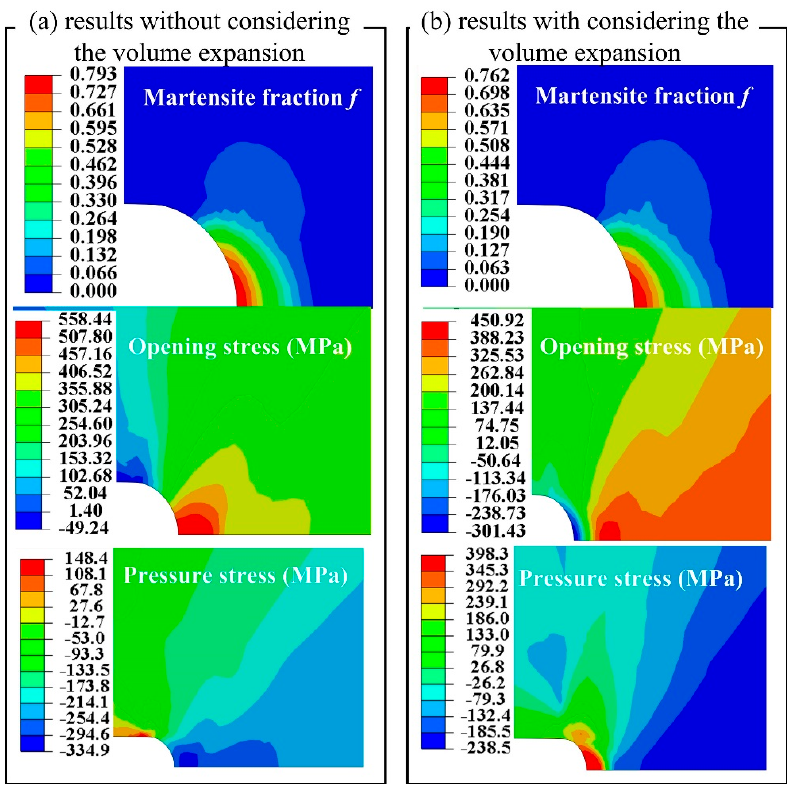
Figure 2. Mechanical analysis results around the crack tip. ( a ) Simulation results without considering the volume expansion and ( b ) simulation results considering the volume expansion.